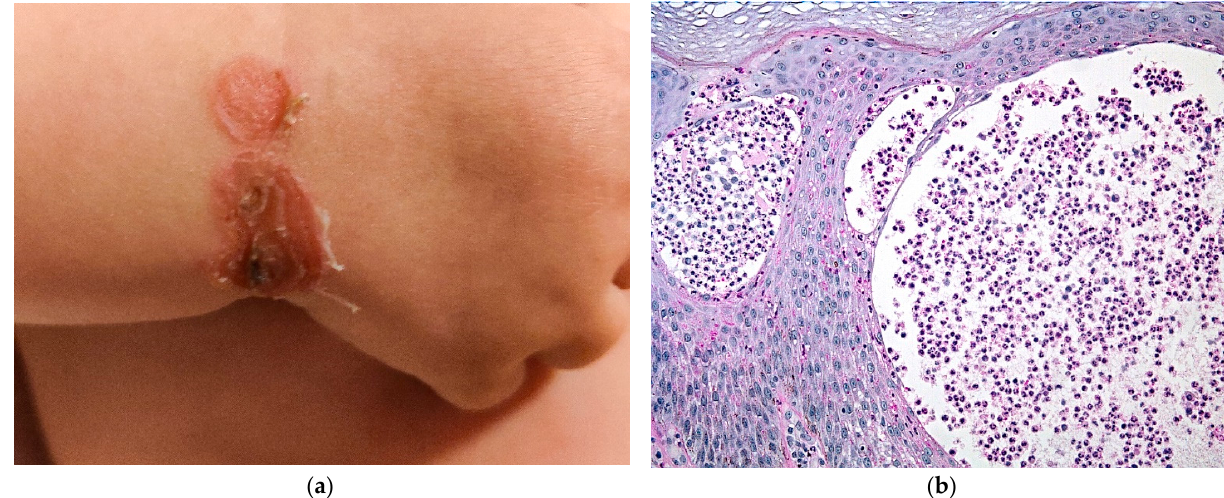
Figure 3. Impetigo. ( a ) Post ‐ bullous lesion of impetigo. ( b ) PAS staining × 20: Impetigo, vesicles filled with neutrophils.